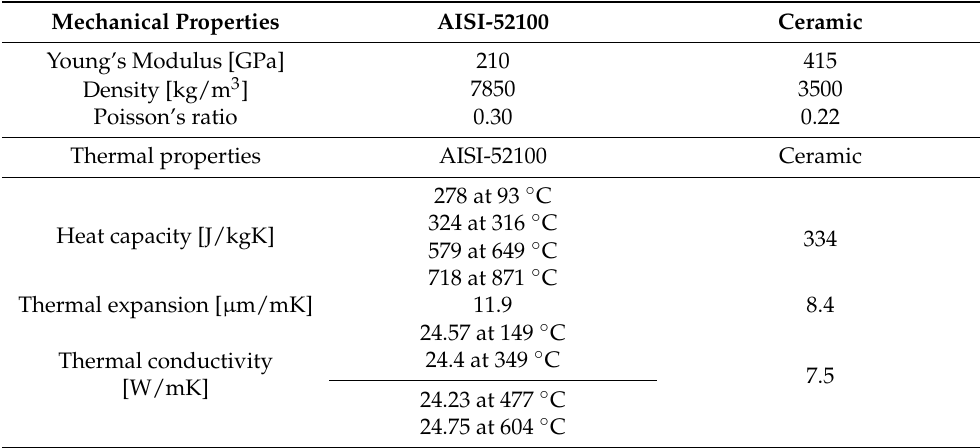
Table 2. Thermo-mechanical properties for the AISI-52100 workpiece [28] and ceramic insert [29]. Mechanical